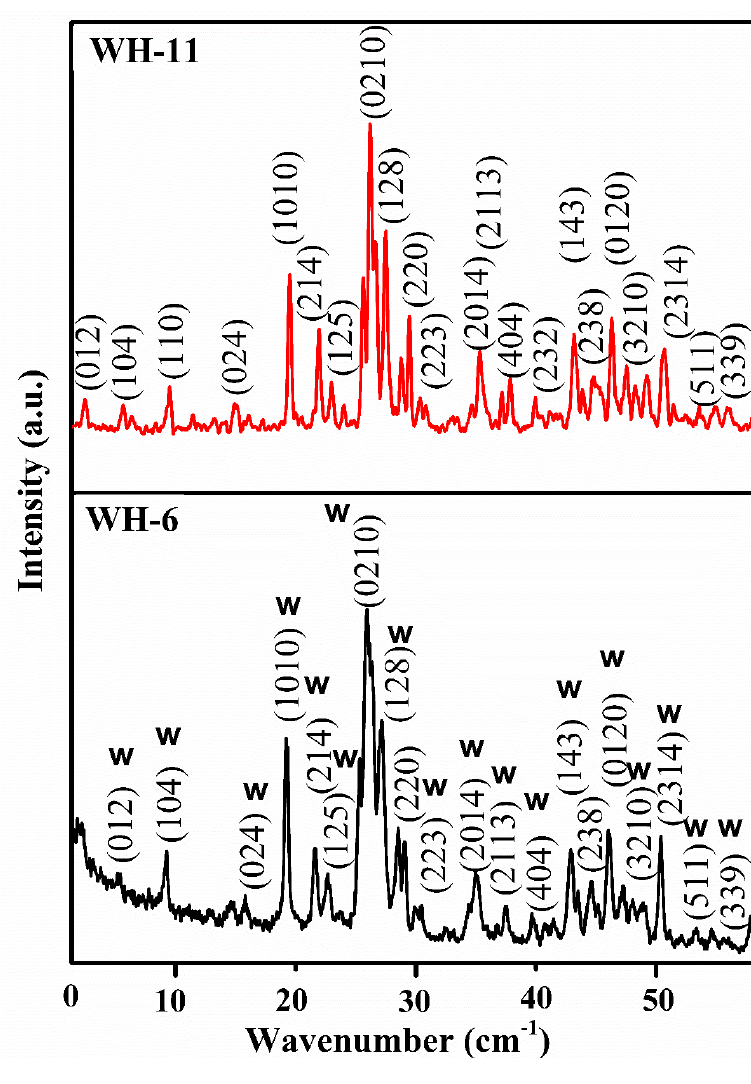
Figure 5. PXRD diffractograms of third batch of product (WH-11) through annealing of WH-6.